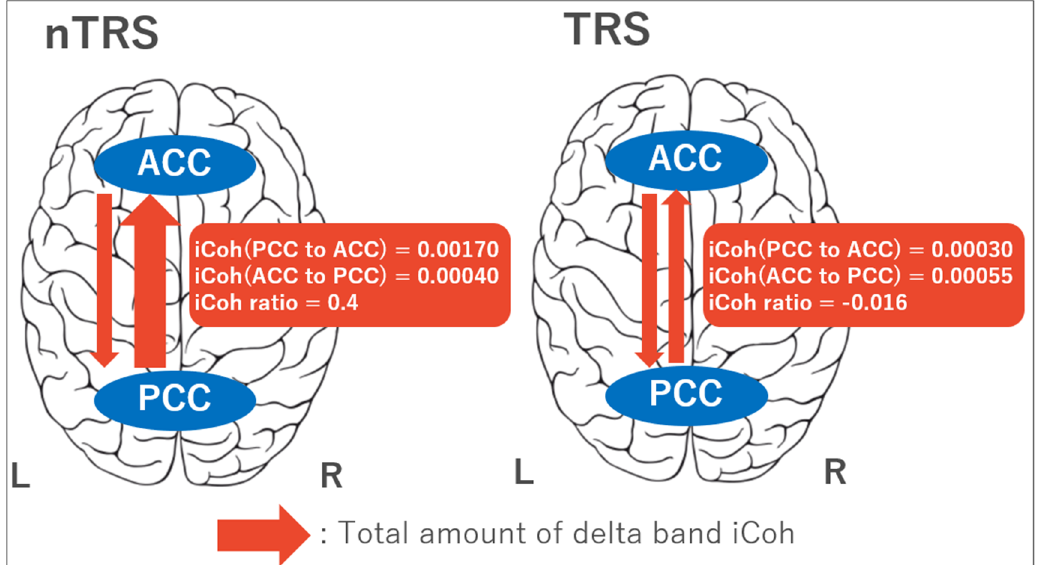
Figure 1. Schematics of the causal effective connectivity between the posterior cingulate cortex (PCC) and anterior cingulate cortex (ACC). In patients with treatment-resistant schizophrenia (TRS), the isolated effective coherence (iCoh) ratios [(PCC to ACC) − (ACC to PCC)]/[(PCC to ACC) + (ACC to PCC)] in delta and theta bands over the left side were significantly decreased compared with patients with non-TRS (nTRS).